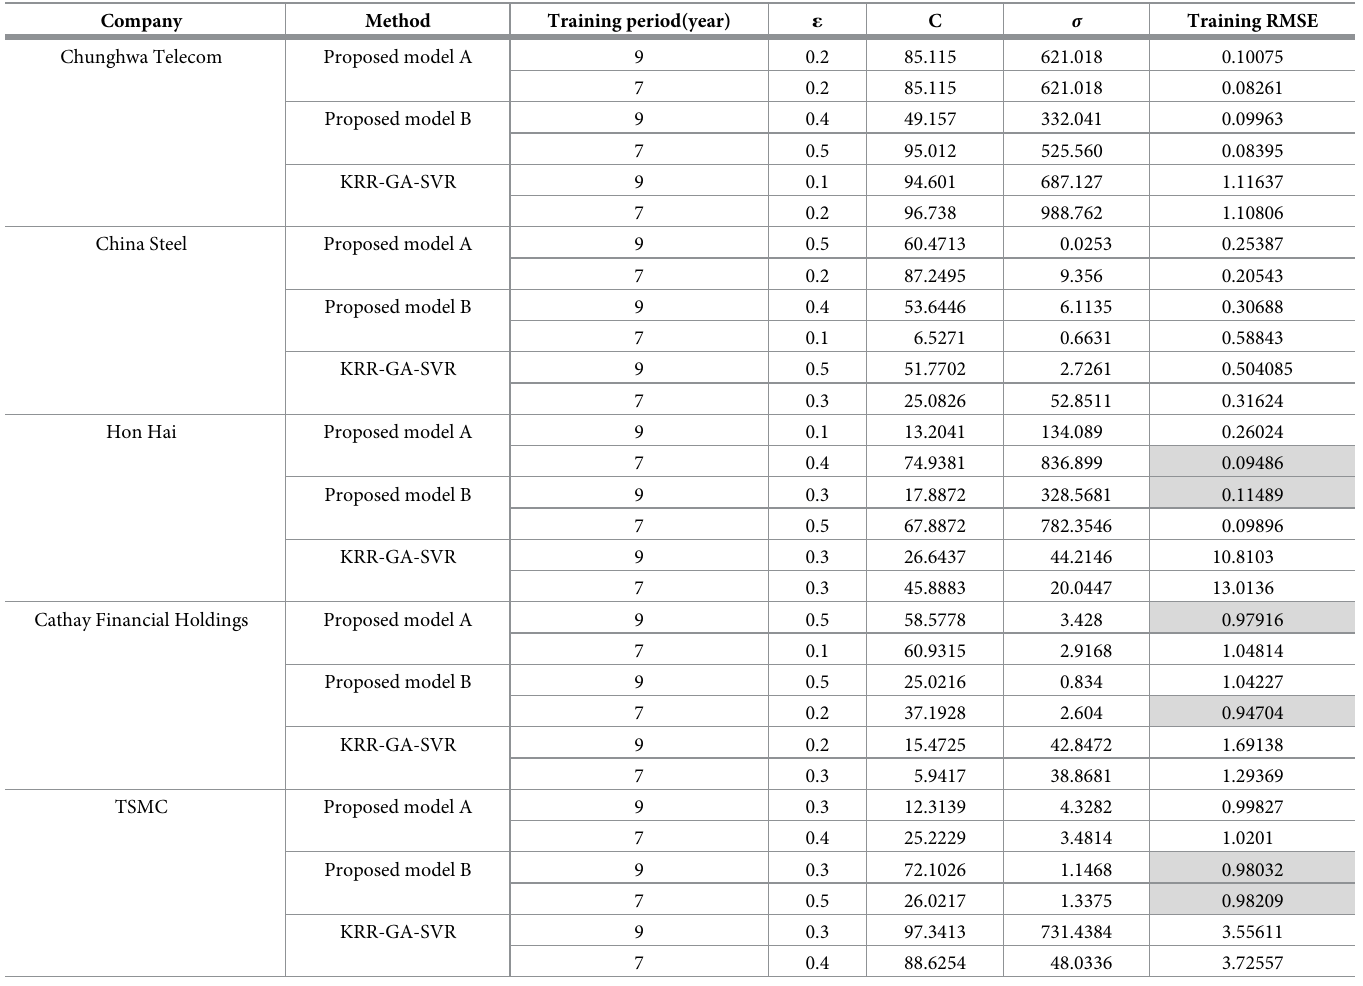
Table 7. The optimal parameters of GA searching for five companies.